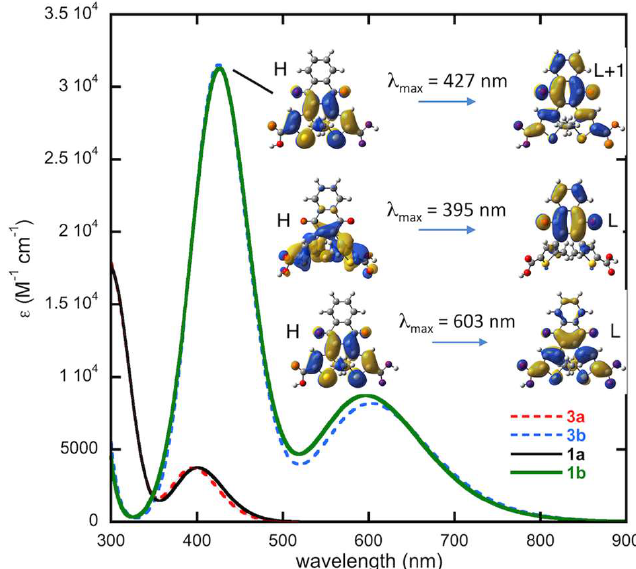
Figure 9. Computed spectrum of 3a and 3b in dichloromethane at TD-DFT level and molecular orbitals (H: HOMO, L: LUMO, isocontour: 0.02) involved in the main electronic transitions. The computed spectra for 1a and 1b are shown for